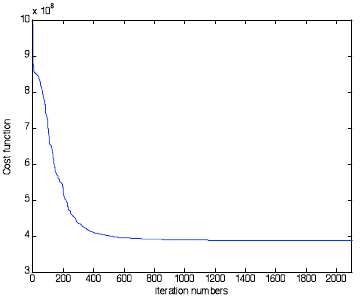
As observed on Fig. 10, parameters using cost function converge rapidly to an optimal value.